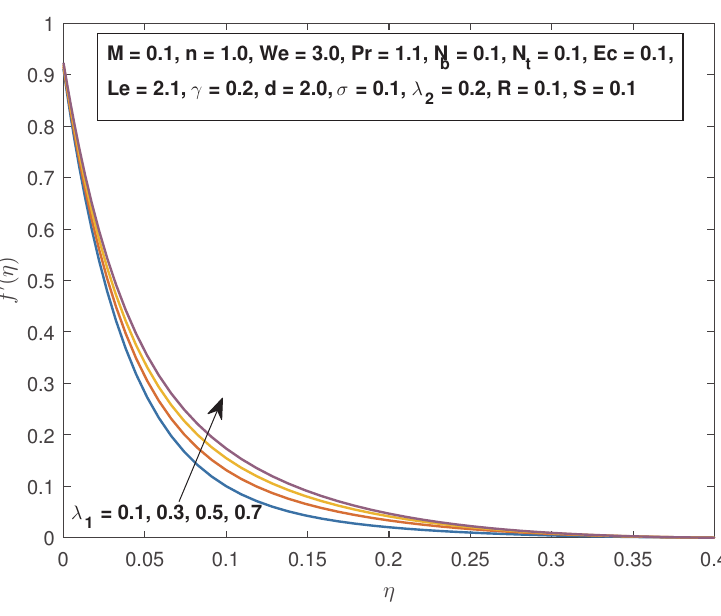
Figure 8. Influence of λ 1 on the fluid velocity.